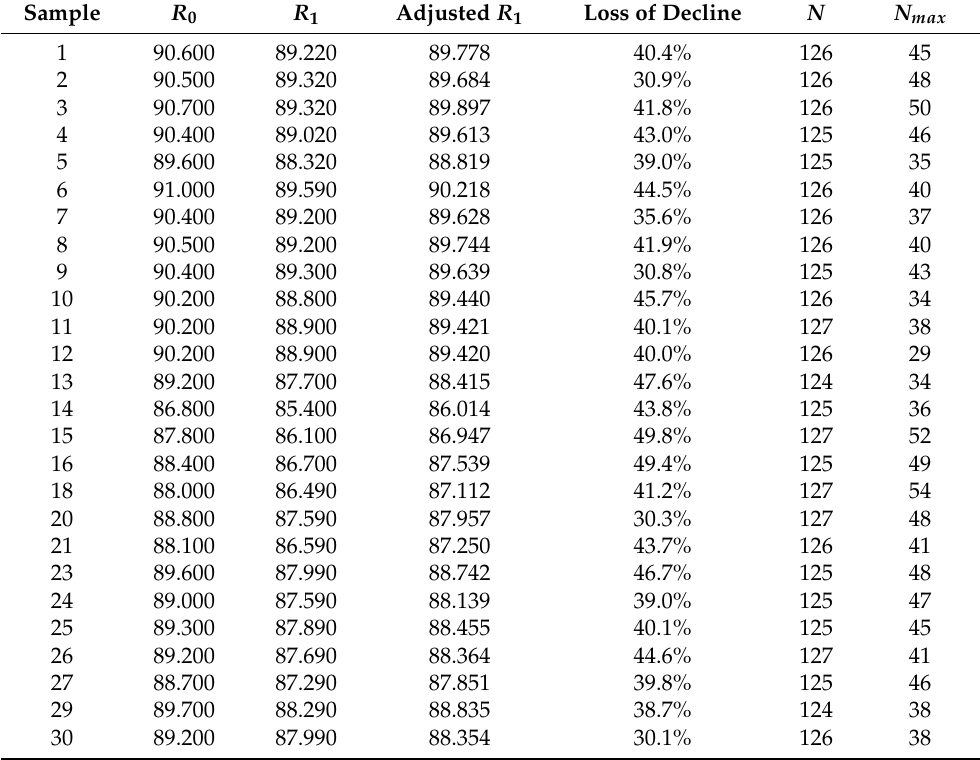
Table 10. Adjustments to the sample with a loss reduction of